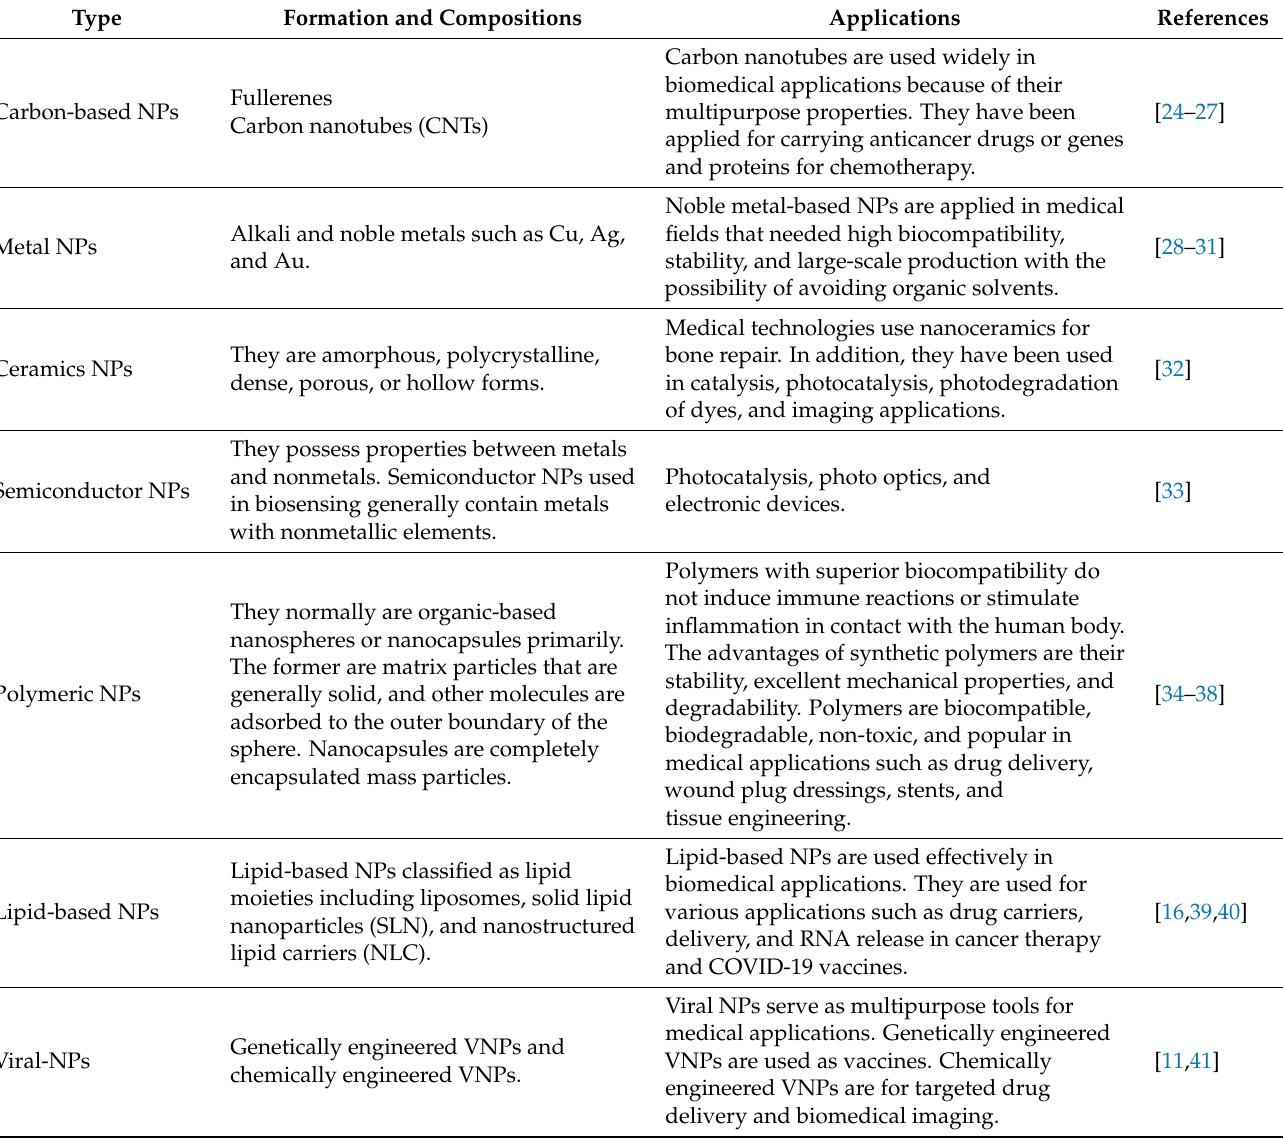
Table 1. Types of nanoparticles and their medical